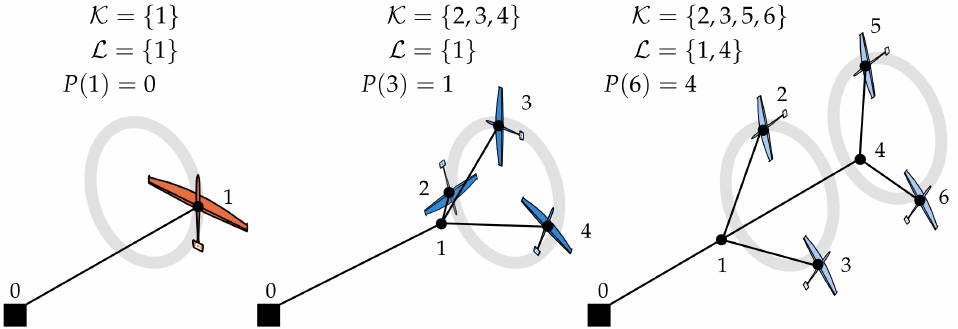
Figure 1. Topologies of a single-aircraft (left), triple-aircraft (middle), and two-layer-dual-aircraft (right) AWE